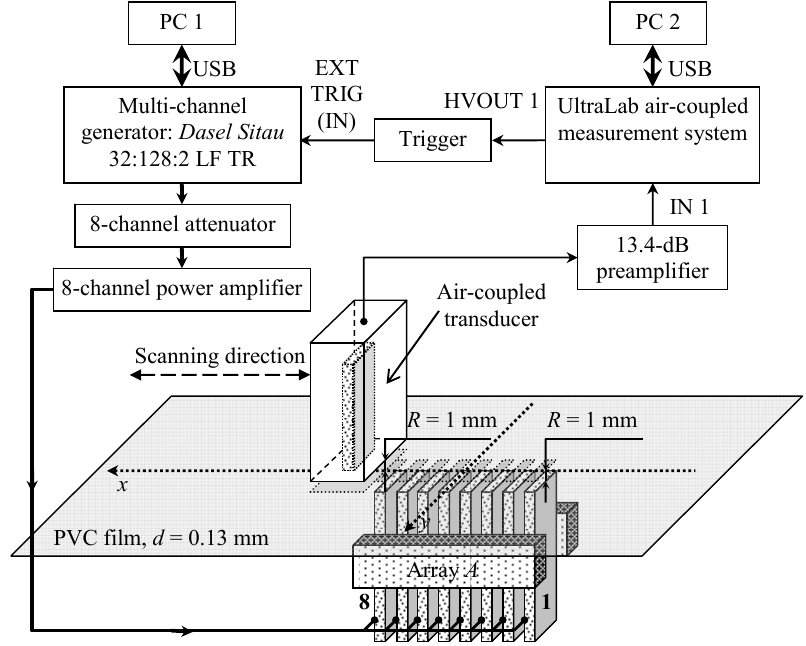
Figure 17. Experimental setup for non-contact generation and reception of A 0 Lamb wave mode.